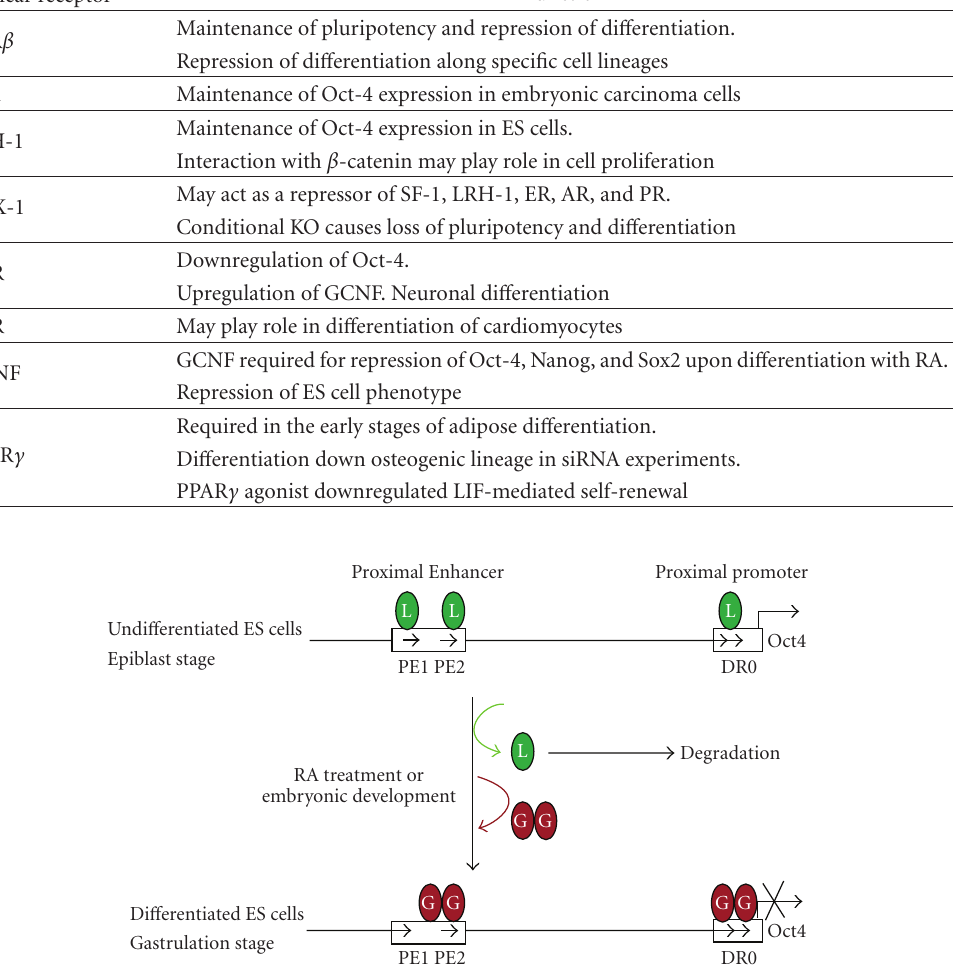
Figure 1: Yin-yang regulation of Oct-4 expression during ES cell di ff erentiation by LRH-1 and GCNF, which compete for the same element. In undi ff erentiated ES cells LRH-1 binds to elements in the Oct-4 proximal enhancer and proximal promoter to maintain its expression during the very earliest stages of di ff erentiation. As di ff erentiation progresses LRH-1 expression decreases and GCNF expression is induced. At an intermediate point GCNF displaces LRH-1 and represses Oct-4 by recruiting the DNA methylation machinery that ultimately leads to the silencing of Oct-4 expression in somatic